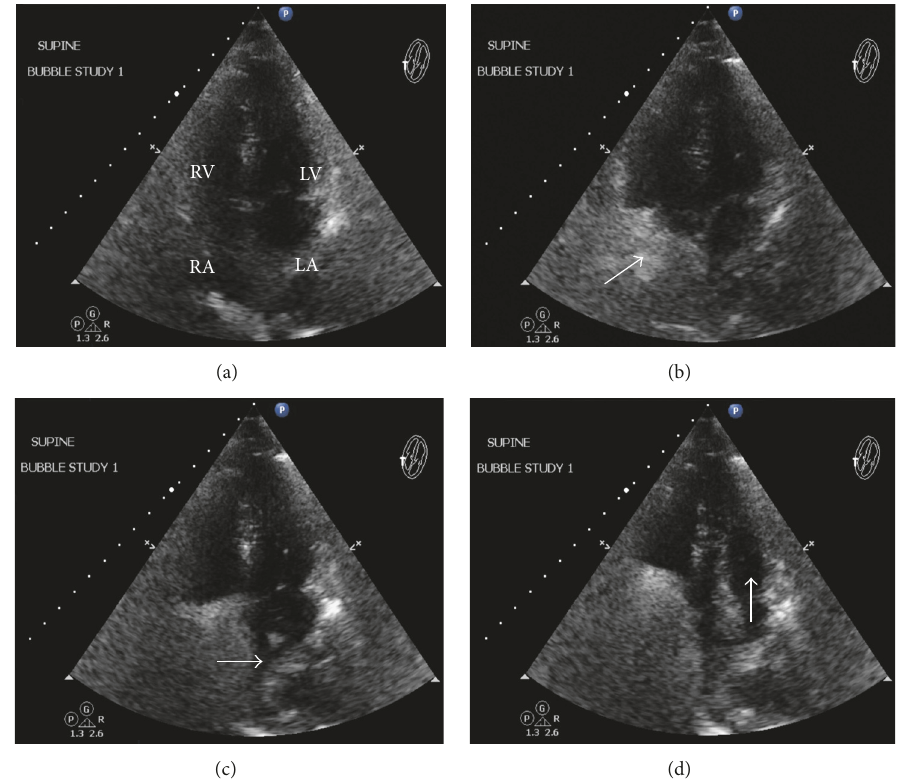
Figure 1: Agitated saline contrast study showing (a) 4 chambers prior contrast infusion. (b) Agitated saline entering the RA. (c) and (d) Arrows demonstrating right-to-left shunt into the LA and LV. RV : right ventricle; LV : left ventricle; RA : right atria; LA : left atria. Arrows throughout indicate direction of the agitated saline